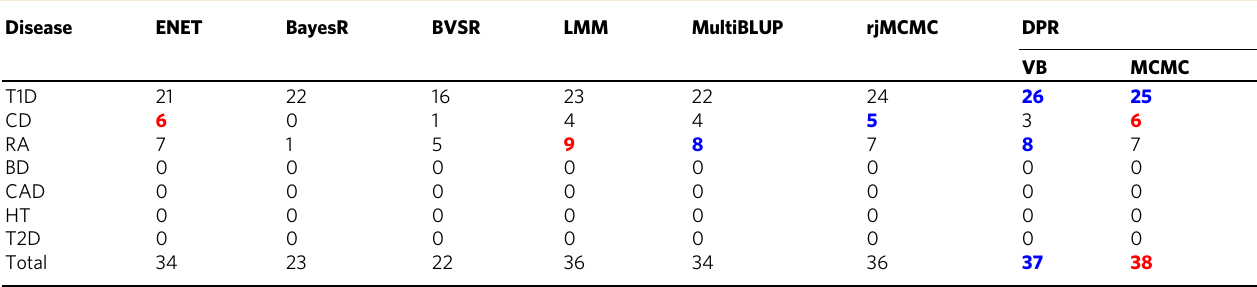
The table lists the number of genes passing the genome-wide signi fi cance threshold via Bonferroni correction ( α = 1.15×10 − 5 ) in each of the seven common diseases. For each disease, we colored the best method with red and the second best method with